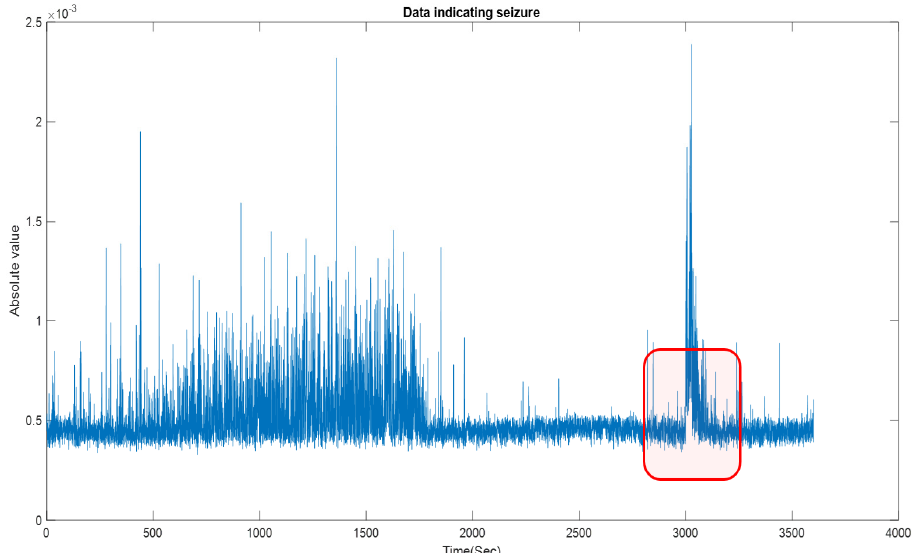
Figure 5. Feature extraction showing the onset of seizure for chb01_03, using the proposed seizure- detection algorithm. The highlighted red box shows the region of seizure.